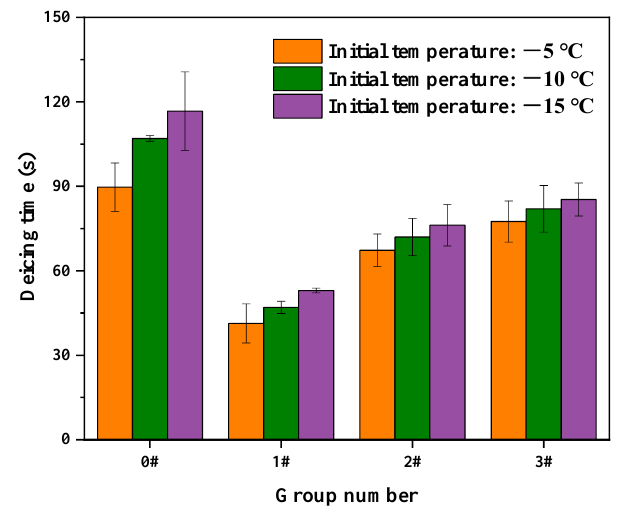
Figure 10. Deicing time of UMLs with different SiC particle sizes.